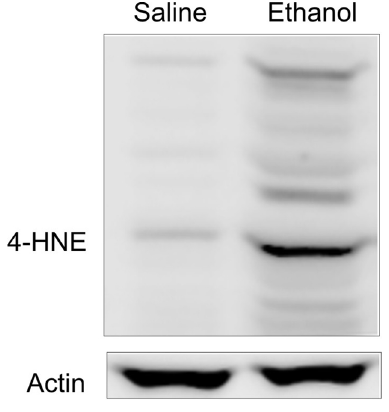
Figure 9. Ethanol increases 4-hydroxynonenal adduct forma- tion. Mice were gavaged with saline or ethanol (6 g/kg). 4-HNE adducts were detected in liver tissue at 6 h after ethanol treatment by immunoblotting. Shown are representative images of gels (n=3 per group).